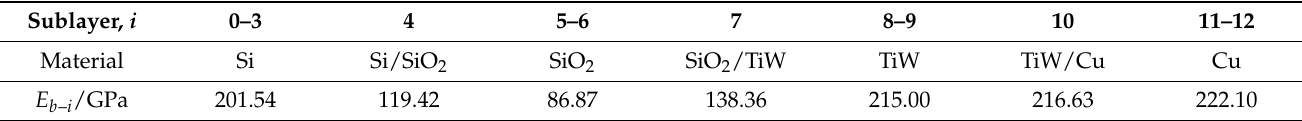
Table 2. As-fabricated samples.